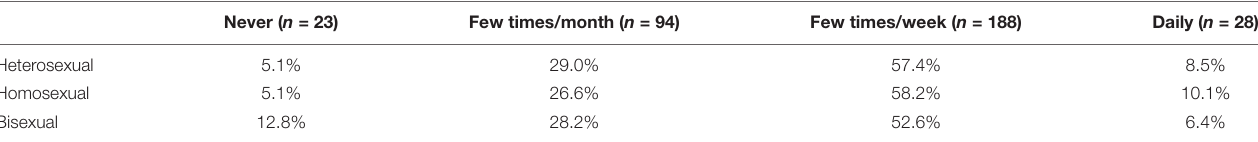
TABLE 1 | Frequency of sexual activity by sexual orientation.